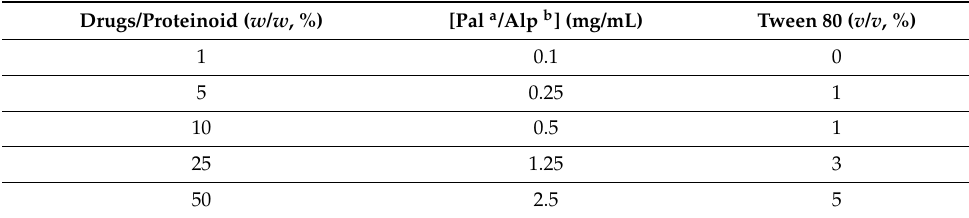
Table 1. Components used for synthesis of drug loaded